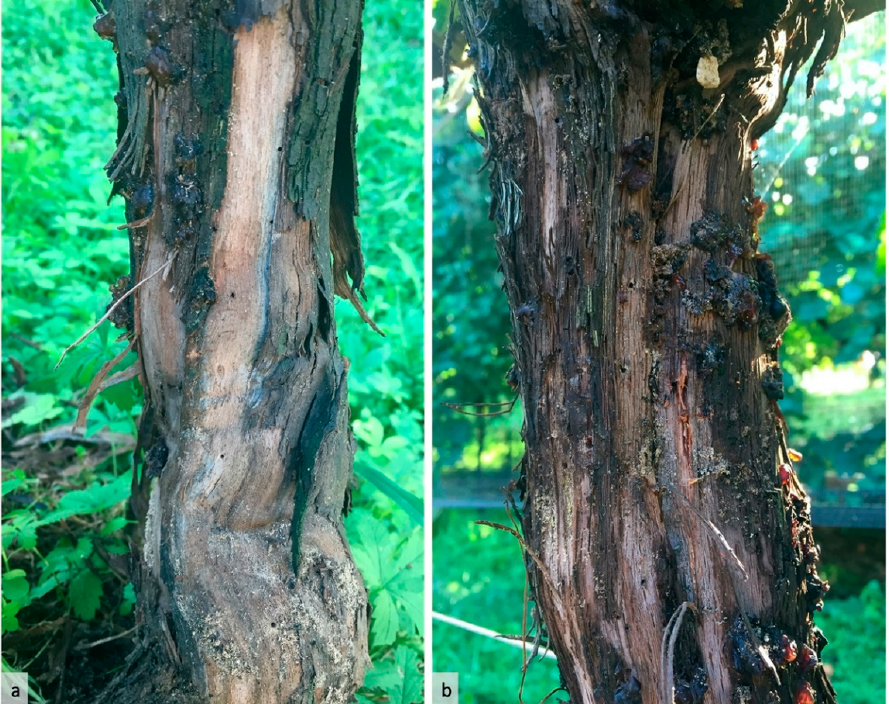
Figure 2. Infestation of Xylosandrus germanus on Vitis vinifera : tunneling concentrated in the proximity of the graft union ( a ) and at the head of the grapevine ( b ).